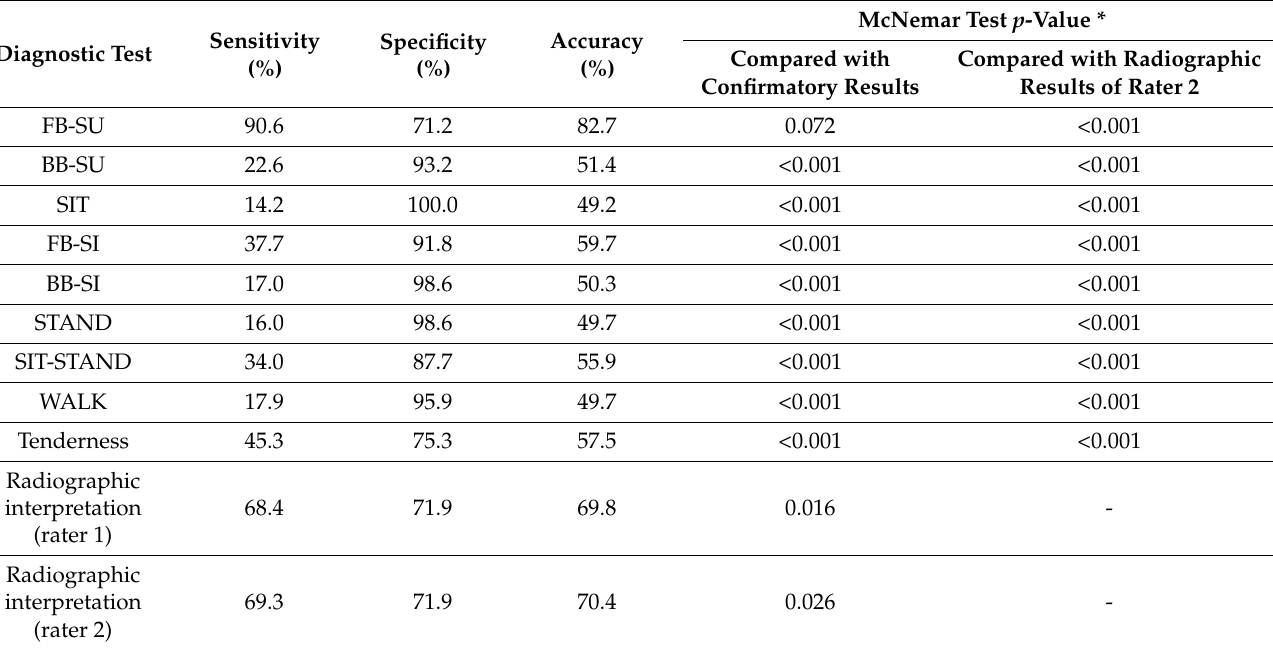
Table 2. Diagnostic values of physical examinations and radiograph interpretations.